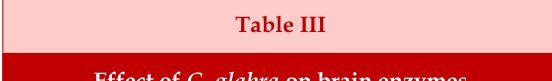
Effect of G. glabra on brain enzymes